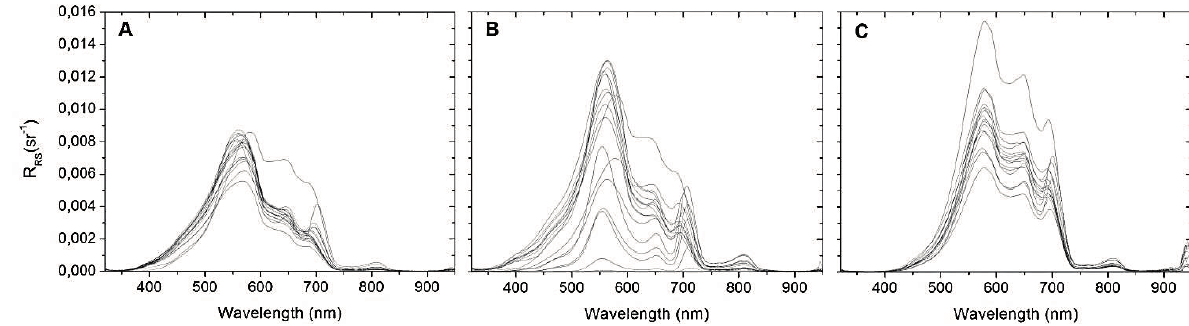
Figure 5. R RS spectra from Funil reservoir in: ( A ) May 2012; ( B ) September 2012 and ( C ) April